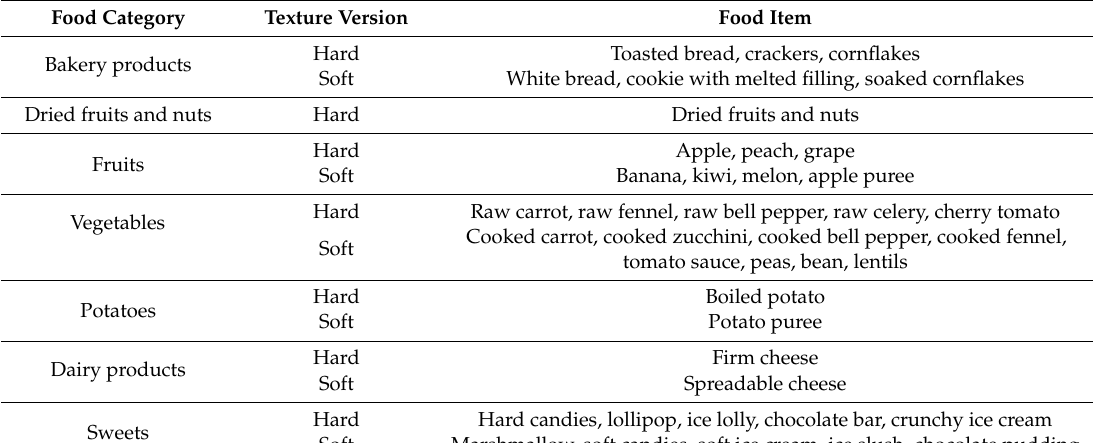
Table 2. Categorization of food items according to